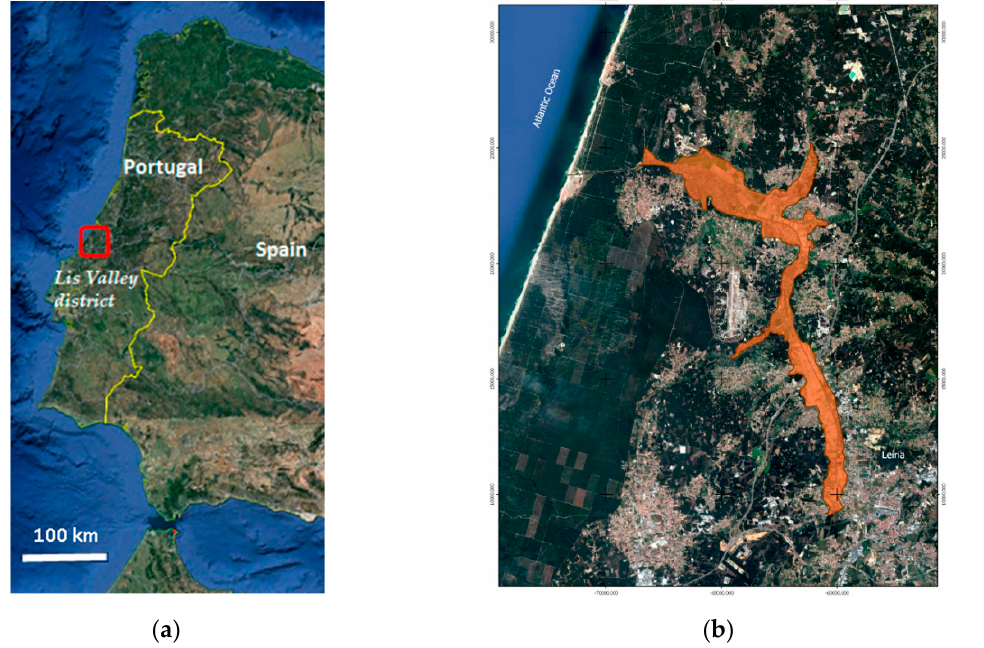
Figure 1. Location of the Lis Valley Irrigation District ( a ) in Portugal and ( b ) in Leira and Marinha Grande counties (source: Google Maps, https://maps.google.pt).